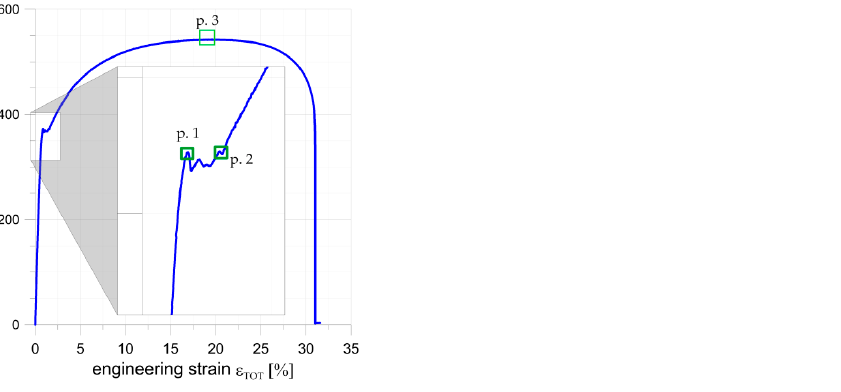
Figure 6. Engineering stress–strain curve obtained for sample 1 made of S355J2+N.